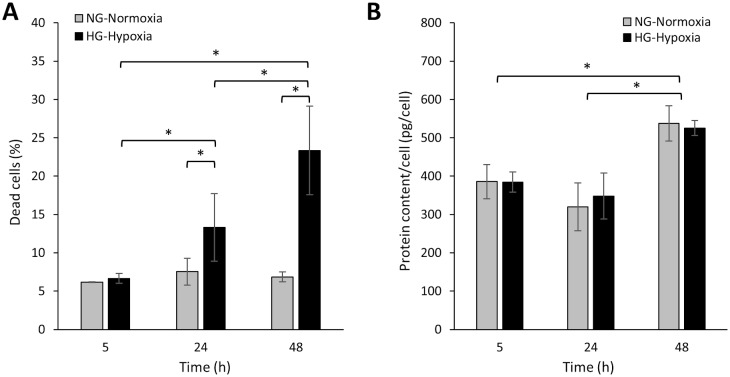
Percentage of dead cells (A) and protein content/cell (B) after incubation of HK-2 cells in NG (5.5 mM glucose)-normoxia (21% O2) or HG (25 mM glucose)-hypoxia (1% O2).Error bars are given as the standard deviation of three independent experiments. *Asterisks indicate significant differences between samples after ANOVA with LSD Post-hoc, p-value < 0.05.